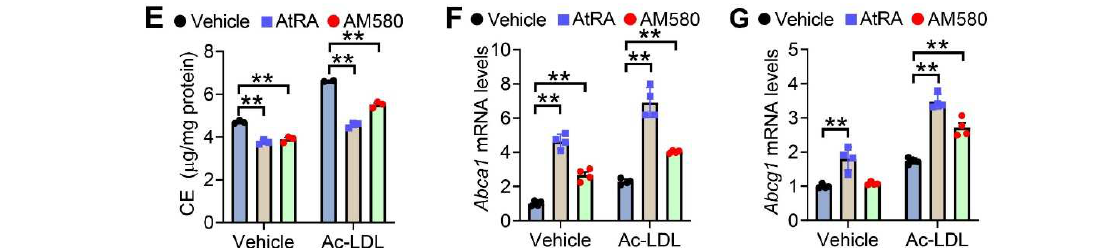
Figure 1. Activation of RAR signaling attenuates lipid accumulation in RAW246.7 cells. ( A – E ) Raw246.7 cells were treated with vehicle or acetylated LDL (Ac-LDL, 25 µg/mL), AtRA (2 µM), or AM580 (2 µM) for 48 h ( n = 3). Intracellular levels of triglycerides (TG) ( A ), non-esterified fatty acids (NEFA) ( B ), total cholesterol (TC) ( C ), free cholesterol (FC) ( D ), and cholesterol esters (CE) ( E ) were determined. ( F , G ) Raw246.7 cells were treated with vehicle or Ac-LDL (25 µg/mL), AtRA (2 µM), or AM580 (2 µM) for 24 h ( n = 4). Abca1 ( F ) or Abcg1 ( G ) mRNA levels were determined. In ( A – G ), ordinary two-way ANOVA with Tukey’s multiple comparisons test was used for statistical analysis.